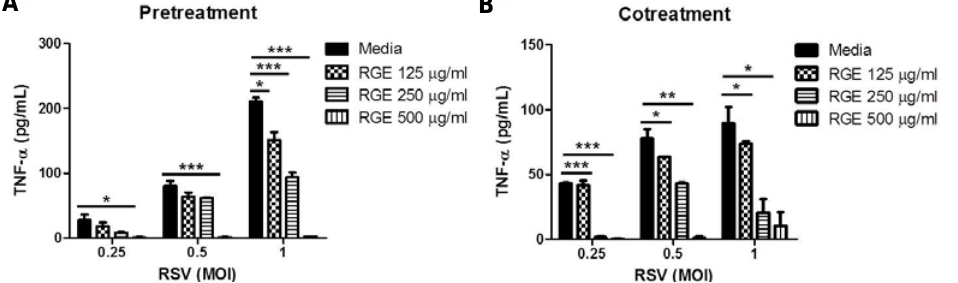
Figure 4. Red ginseng extract (RGE) inhibits respiratory syncytial virus (RSV)-induced cytokine production in dendritic cells. DC2.4 dendritic cells were mock-infected or infected with RSV at different MOIs. DC2.4 dendritic cells were treated with RGE 24 h prior to infection or during the infection period. Concentrations of TNF-α in the culture supernatants were determined using an ELISA kit. ( A ) Pre-treatment of RGE on DC2.4 dendritic cells infected with RSV at different MOIs; ( B ) Co-treatment of RGE on DC2.4 dendritic cells infected with RSV at different MOIs. Values are the mean ± SEM. * p < 0.05; ** p < 0.01; *** p <